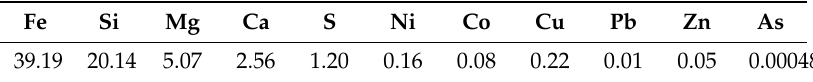
Table 1. Compositions of nickel slag (wt %).